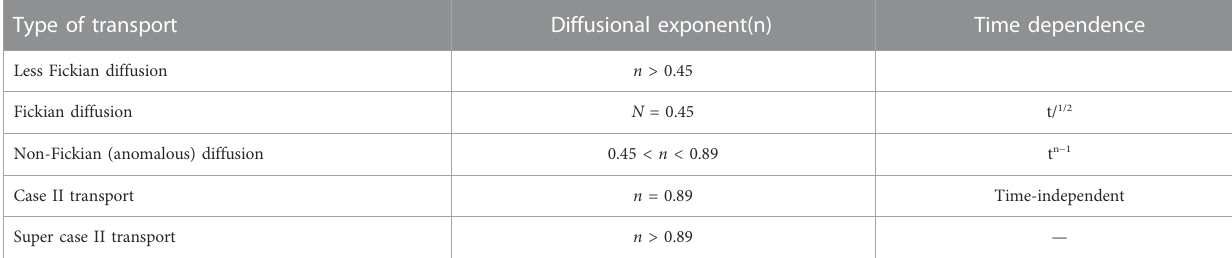
TABLE 2 Drug transport processes and the diffusional exponent n, which speci fi es whether the drug diffusion is Fickian or non-Fickian from the release system. Type of